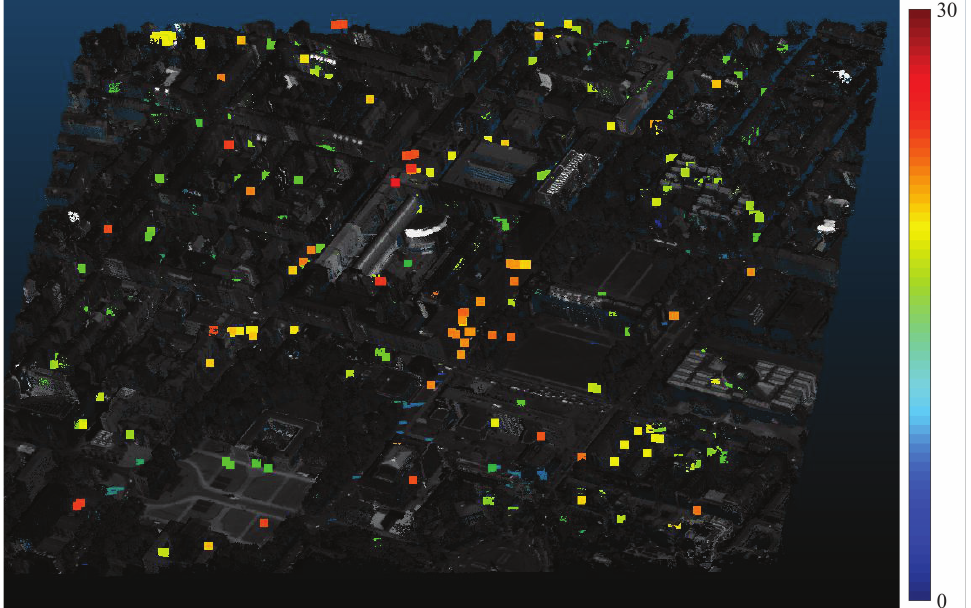
Figure 6. Visualization of the reconstruction result overlayed to the texturized LiDAR reference point cloud. The reconstructed points are colorized by their heights relative to the 560-meter horizontal plane in the UTM system.